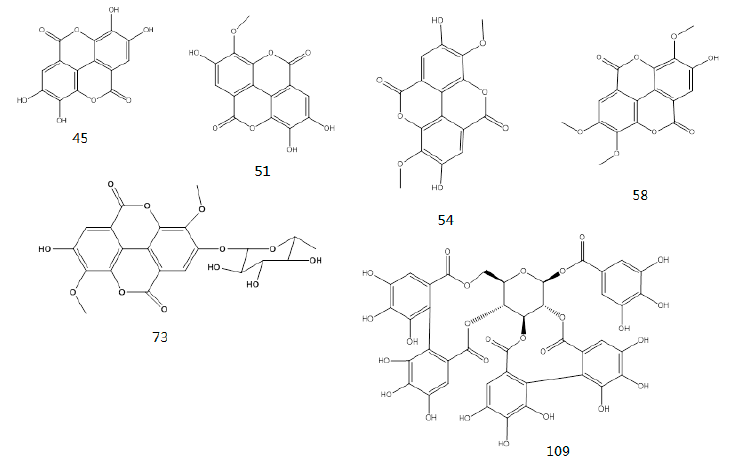
Figure 6. Structure of tannins.